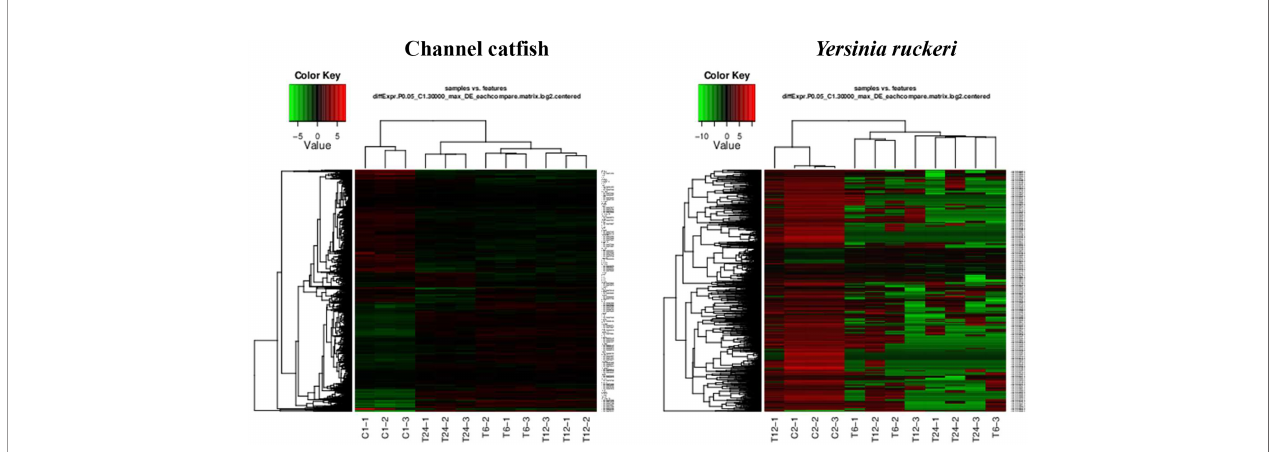
FIGURE 2 | The gene expression pro fi les for channel cat fi sh and Y. ruckeri using pattern clustering. Red represents the upregulated genes, green represents the downregulated genes. Each line represents a single gene. C1 and C2 as control group, T6, T12 and T24 represents the experimental group in 6 hpi, 12 hpi and 24 hpi.